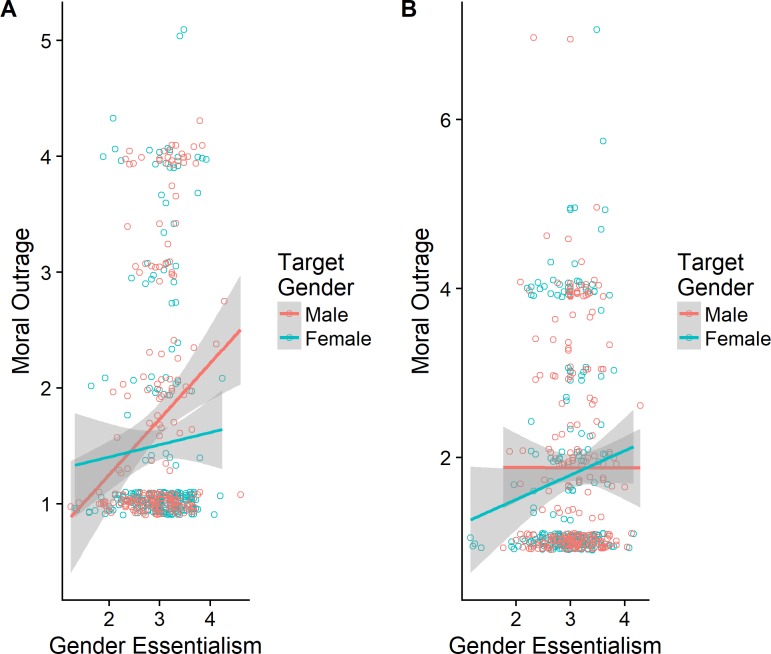
The effects of gender essentialism and target gender on moral outrage ratings.The figure represents the data points with .1 jitter added to avoid overplotting, the fitted linear trend for each condition, and 95% confidence intervals.